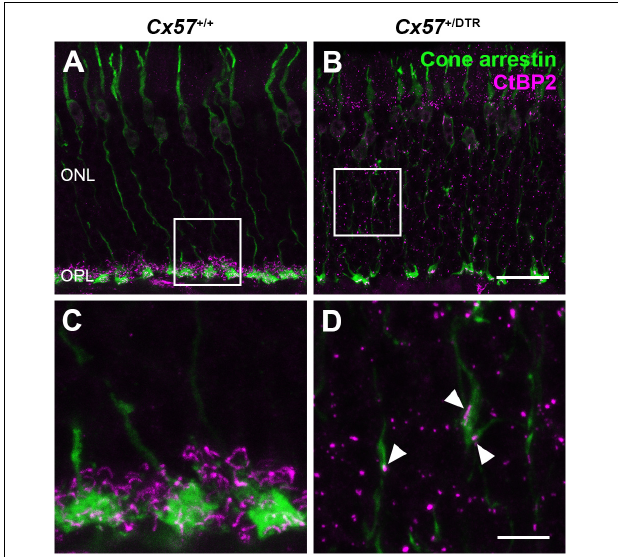
FIGURE 5 | Ribbons in new cone terminals. (A–D) Double staining of vertical sections from Cx57 + / + and Cx57 + / DTR mice (P56) for cone arrestin, a cone marker (green), and CtBP2 (magenta), a synaptic ribbon marker. In the outer retina of wild-type mice, ribbons were horseshoe shaped and confined to the OPL (A,C) . By contrast, ribbons in horizontal cell-ablated mice were smaller and distributed over the entire ONL (B,D) . In addition, CtBP2-postive structures were frequently found in ectopic cone terminals (arrowheads) (D) . Scale bars, 20 µ m (B) , 5 µ m (D)